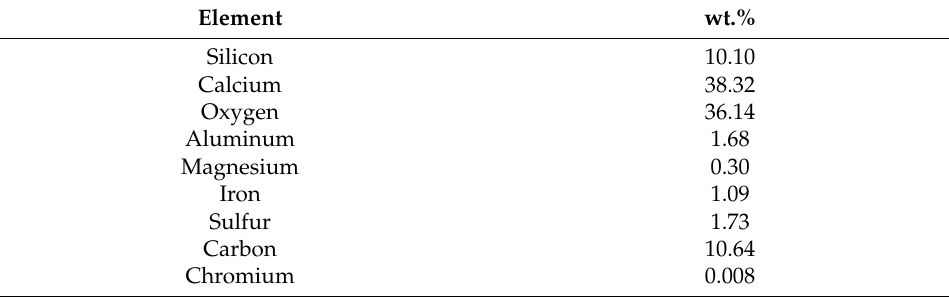
Figure 6. EDS maps showing inhomogeneous elemental distribution in particles. Table 3. Elemental composition of cement dust from EDS.